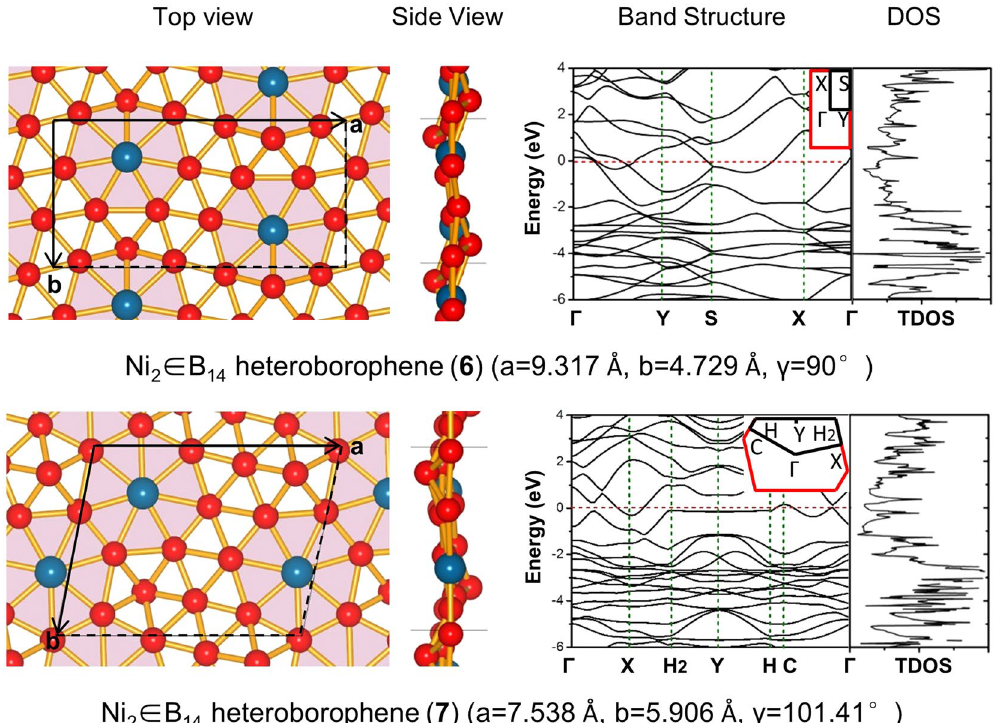
Figure 4. Top and side views of the structures of 2D heteroborophenes. Ni 2 ∈ B 14 ( 6 ) and Ni 2 ∈ B 14 ( 7 ) were optimized at PBE and their band structures and total densities of states (TDOS) were calculated at HSE06. The insets represent the shapes of first Brillouin zones. Γ , X, A and Z of ( 6 ) correspond to the (0, 0, 0), (0, 0.5, 0), (0.5, 0.5, 0) and (0.5, 0, 0) k-points, while Γ , X, H 2 , Y, H and C of ( 7 ) correspond to the (0, 0, 0), (0.5, 0, 0), (0.440, 0.389, 0), (0, 0.5, 0), ( − 0.440, 0.611, 0) and ( − 0.5, 0.5, 0)